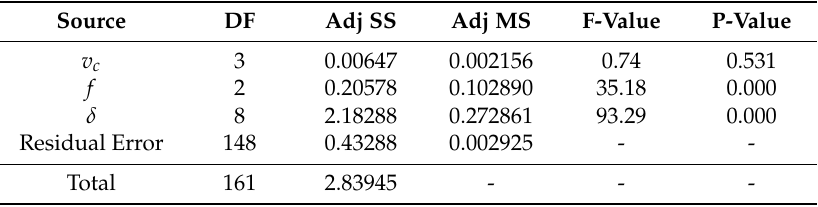
Table 4. Analysis of ANOVA variance for surface roughness parameter Ra.